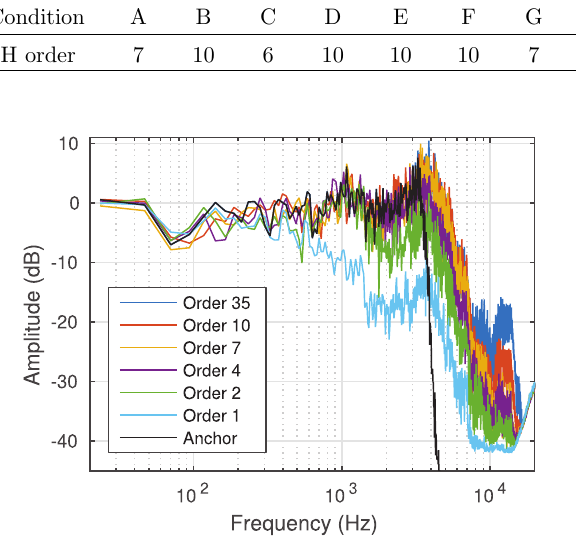
Figure 2. Spectra of the left binaural impulse responses in the meeting room when speaker and listener face each other, for various SH orders of the speaker signal and the anchor (low-pass fi ltered version of the signal at order 35) of the